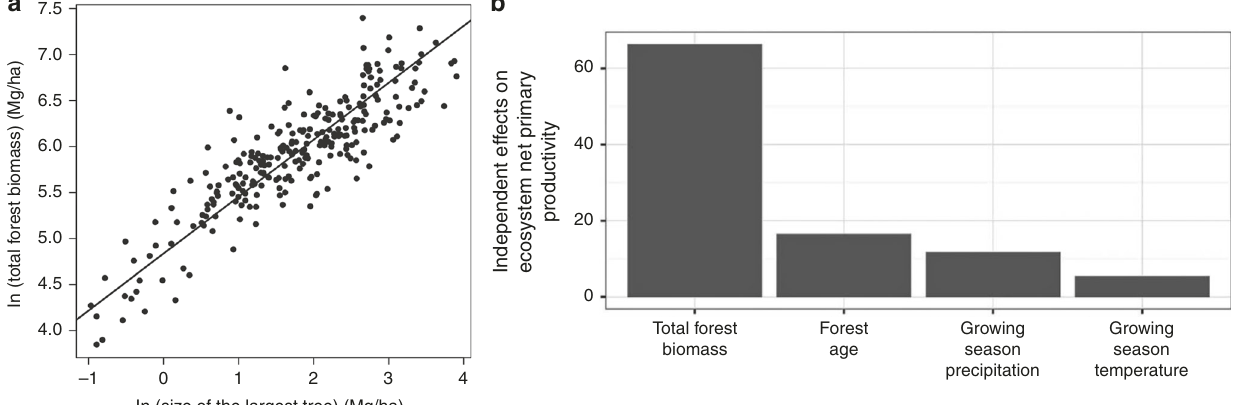
Fig. 3 Forests with larger trees disproportionately store more biomass (carbon) and are more productive. In ( a ) the total above ground forest biomass is best predicted by the size of the largest tree. Analysis of biomass calculated from n = 267 independent forest plots distributed across the Americas from 40.7° S to 54.6° N latitude. The best single predictor of variation in forest biomass is the size of the largest tree in that forest. The fi tted slope of the relationship (the scaling exponent) is 0.62, which is indistinguishable from the predicted scaling function from metabolic scaling theory where the total biomass should scale as maximum tree size to the 5/8 or 0.625 power. Data from ref. 48 . In ( b ) global analyses of the relative importance of several drivers of variation in forest ecosystem net primary productivity (data from ref. 51 ). The most important driver of variation in terrestrial net primary productivity is the total forest biomass. Variation in forest biomass has a larger effect than precipitation, temperature, and forest age. As the best predictor of total forest biomass is the size of the largest individual ( a ) these results indicate that forests with large mega fl ora are more productive. Vegetation with mega fl ora collectively dominate the biomass and carbon stored in vegetation and the productivity of land